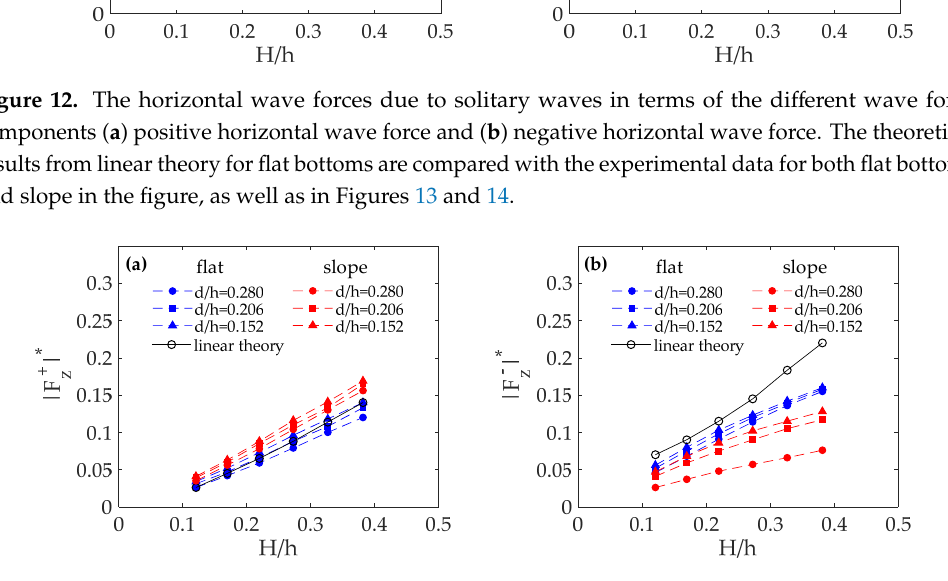
Figure 13. The vertical wave forces due to solitary waves in terms of the different wave force components ( a ) positive vertical wave force and ( b ) negative vertical wave force.